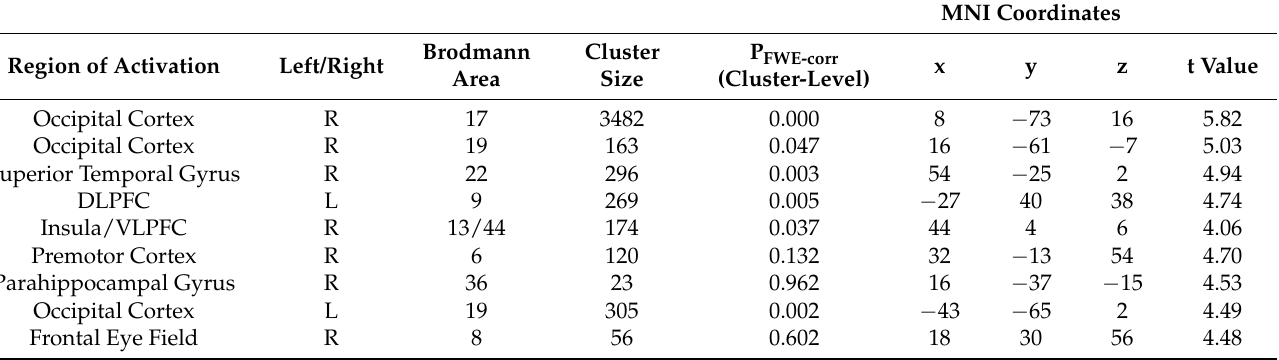
Table 2. Maxima of regions showing significantly reduced fMRI signals in individuals with crystal meth dependence, compared to healthy controls in the incongruent Stroop task condition (voxel-level p < 0.001 uncorr., cluster size ≥ 16, according to the expected voxels per cluster). MNI